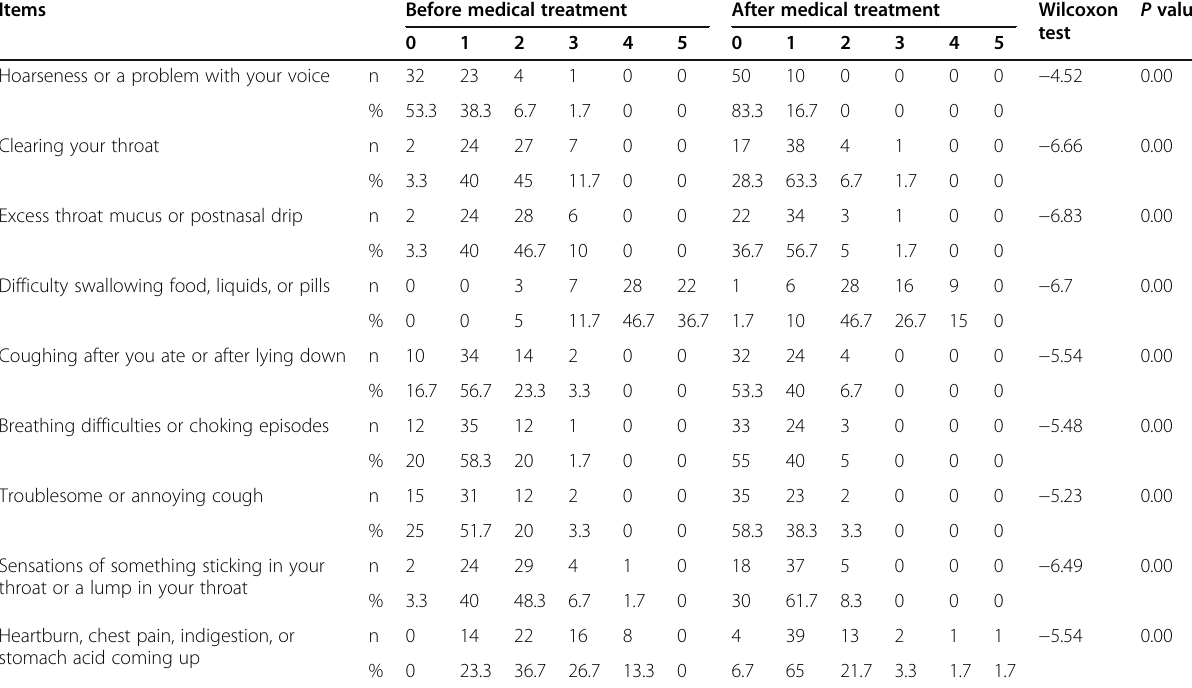
Table 3 Distribution of RSI items before and after medical treatment among the participants Items Before medical treatment After medical treatment